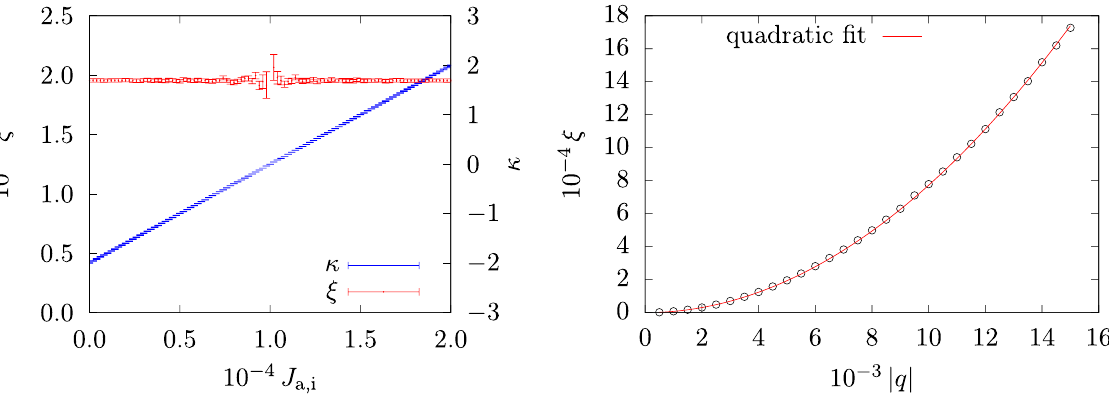
κ exp ½ − ξ ð ω − ω = ϵ (cid:3) for distributions with constant J as in y; f y; i Þ a ¼ a ; i = 2 is linked to the increase of the . The oscillations of the value of ξ when J is close to J a ; i a ; i b 2 . 602 , ω 2 . 5 , x ¼ y ; i ¼ 2 × 10 − 4 b ¼